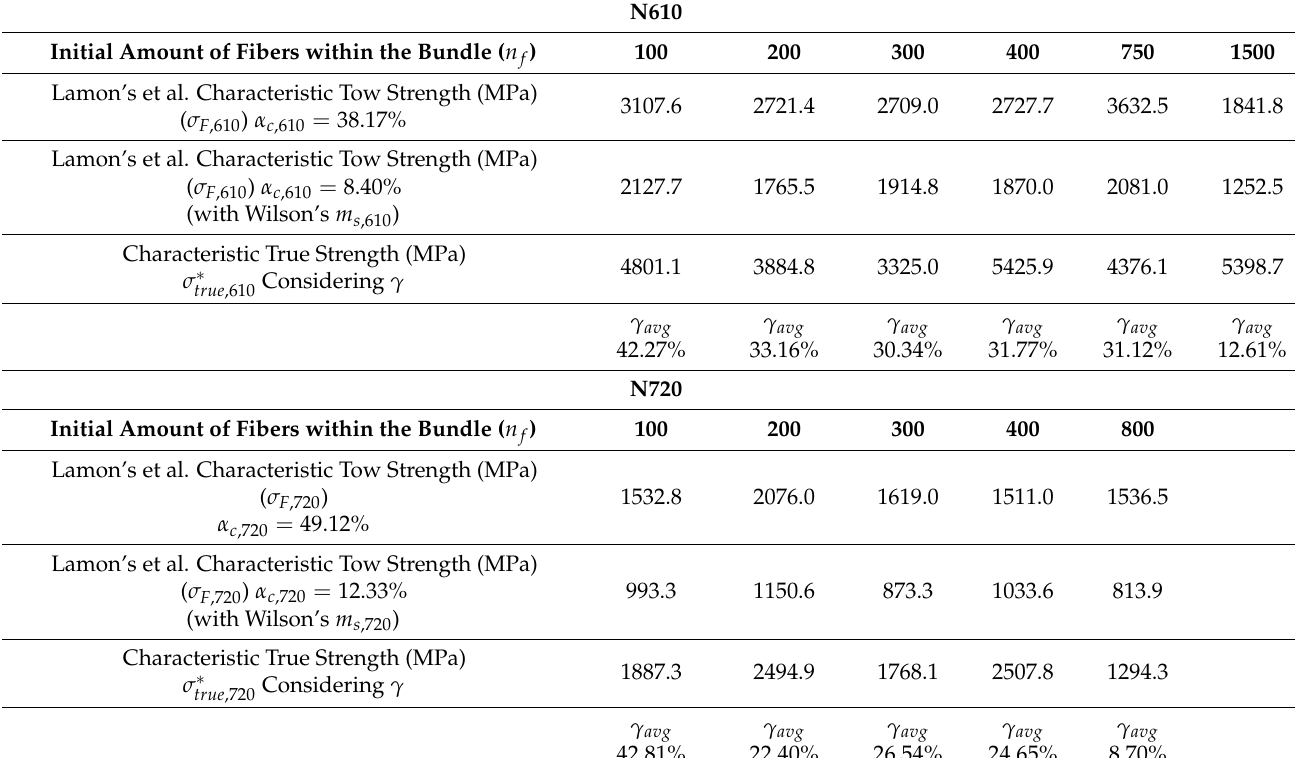
Table 5. Characteristic engineering strength and Weibull moduli for the N610 and N720 samples considering different conditions.